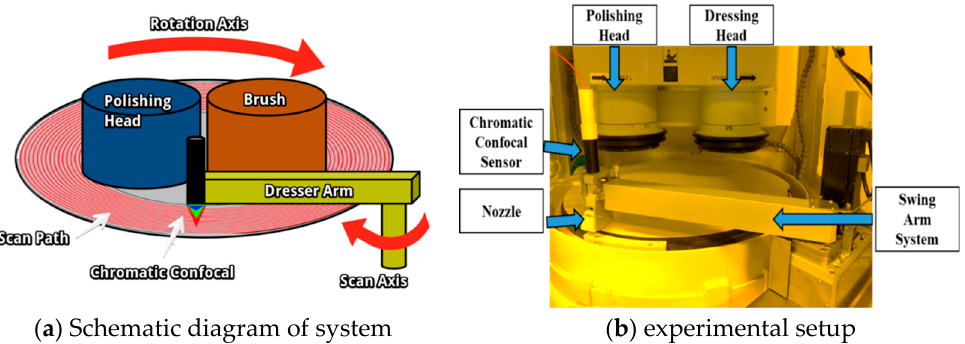
Figure 1. Dynamic swing-arm chromatic confocal system.